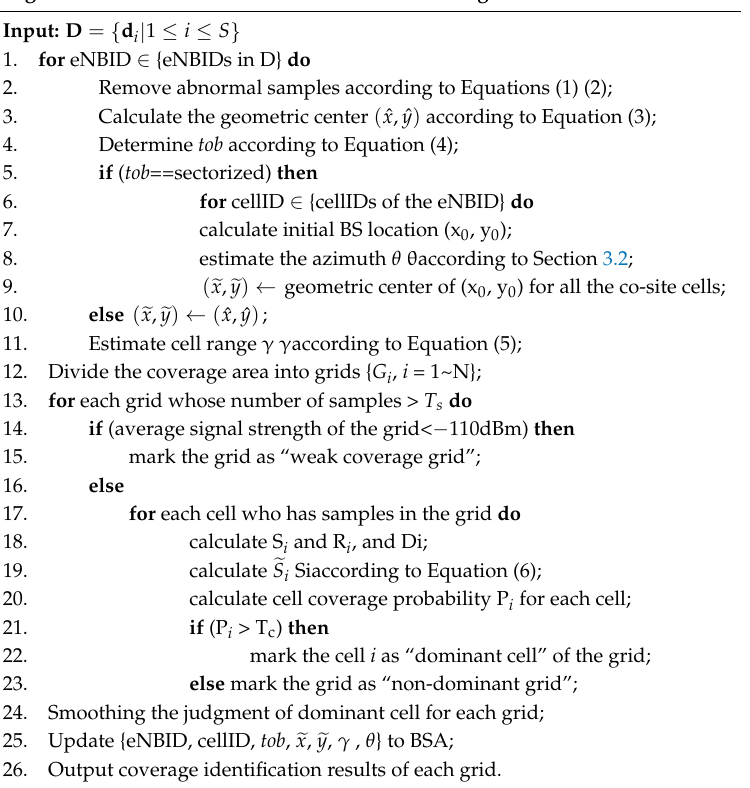
Algorithm 1. BSA information detection and coverage